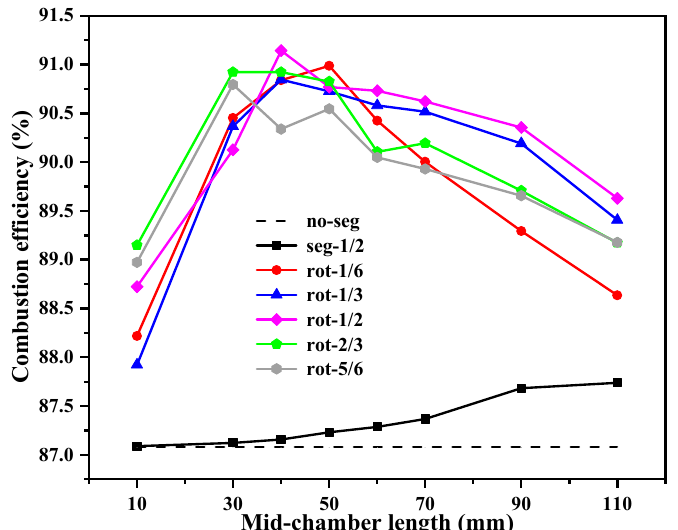
Figure 29. Combustion efficiency in various cases.